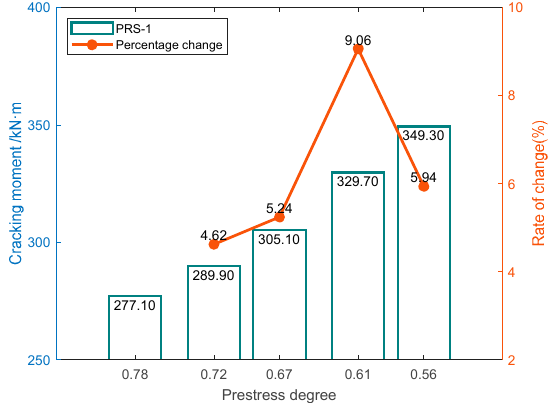
Figure 13. Effect of non-prestressed reinforcement on cracking moment.